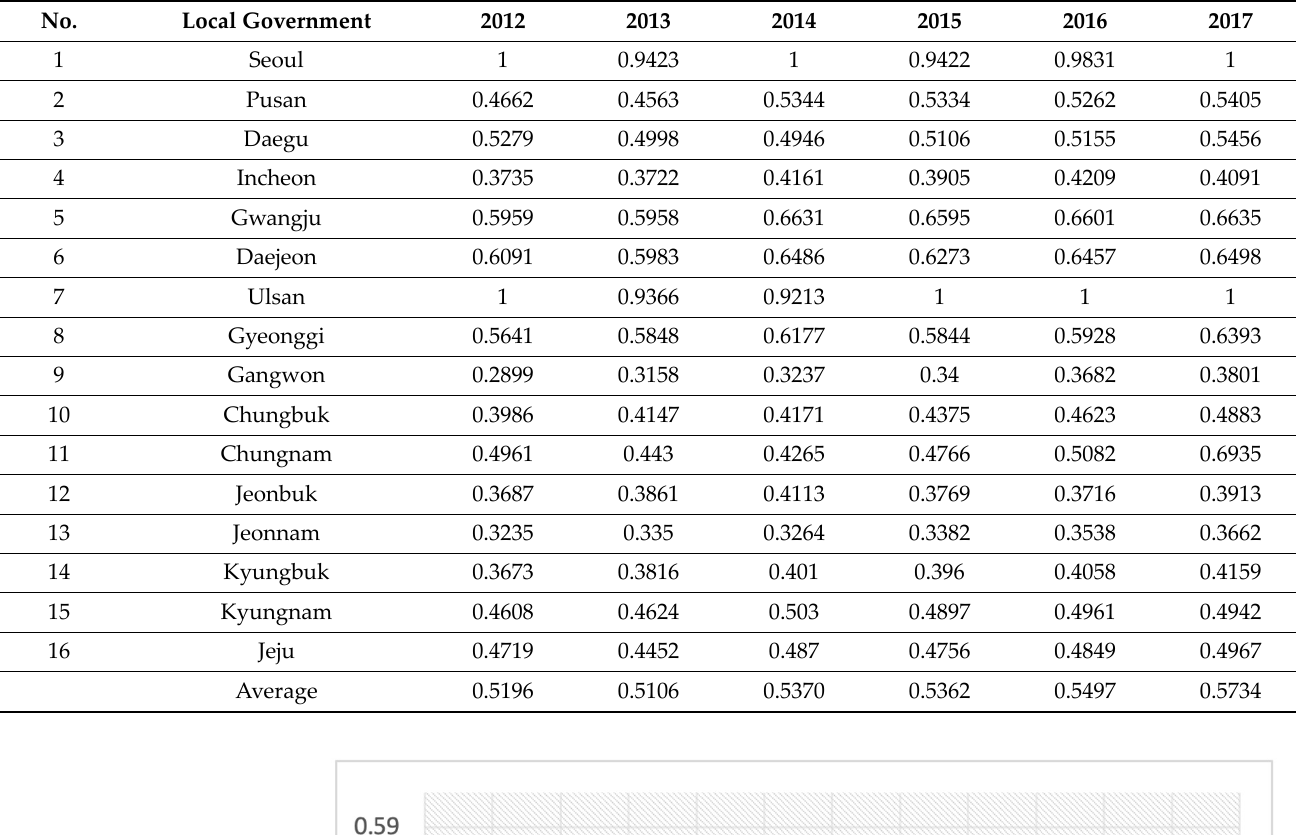
Table 4. PM 2.5 efficiency of 16 local governments, 2012–2017. Table 4. PM2.5 efficiency of 16 local governments, 2012–2017.